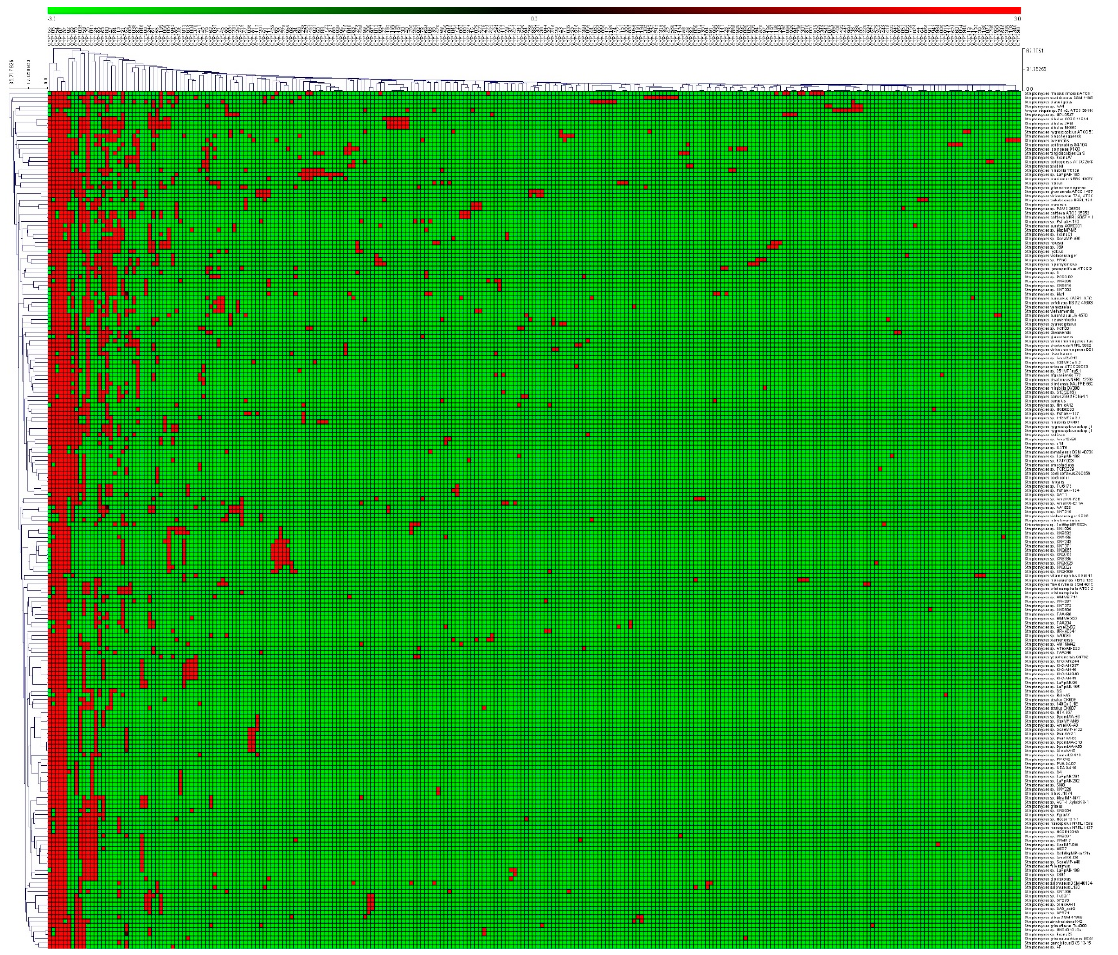
Figure 3. Heat-map of P450 family conservation analysis in Streptomyces species. In the heat-map, the presence and absence of P450 families are indicated in red and green colors. The horizontal axis represents P450 families and the vertical axis represents Streptomyces species.